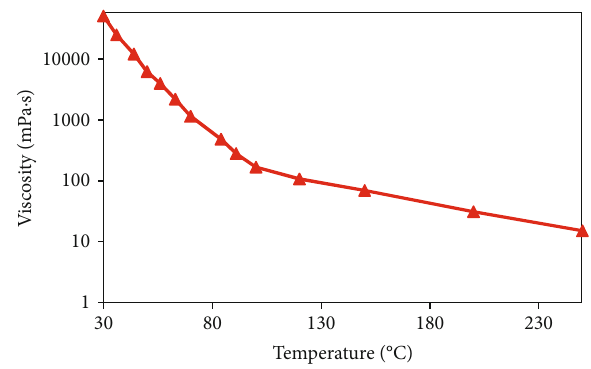
Figure 1: Viscosity-temperature curve of heavy oil